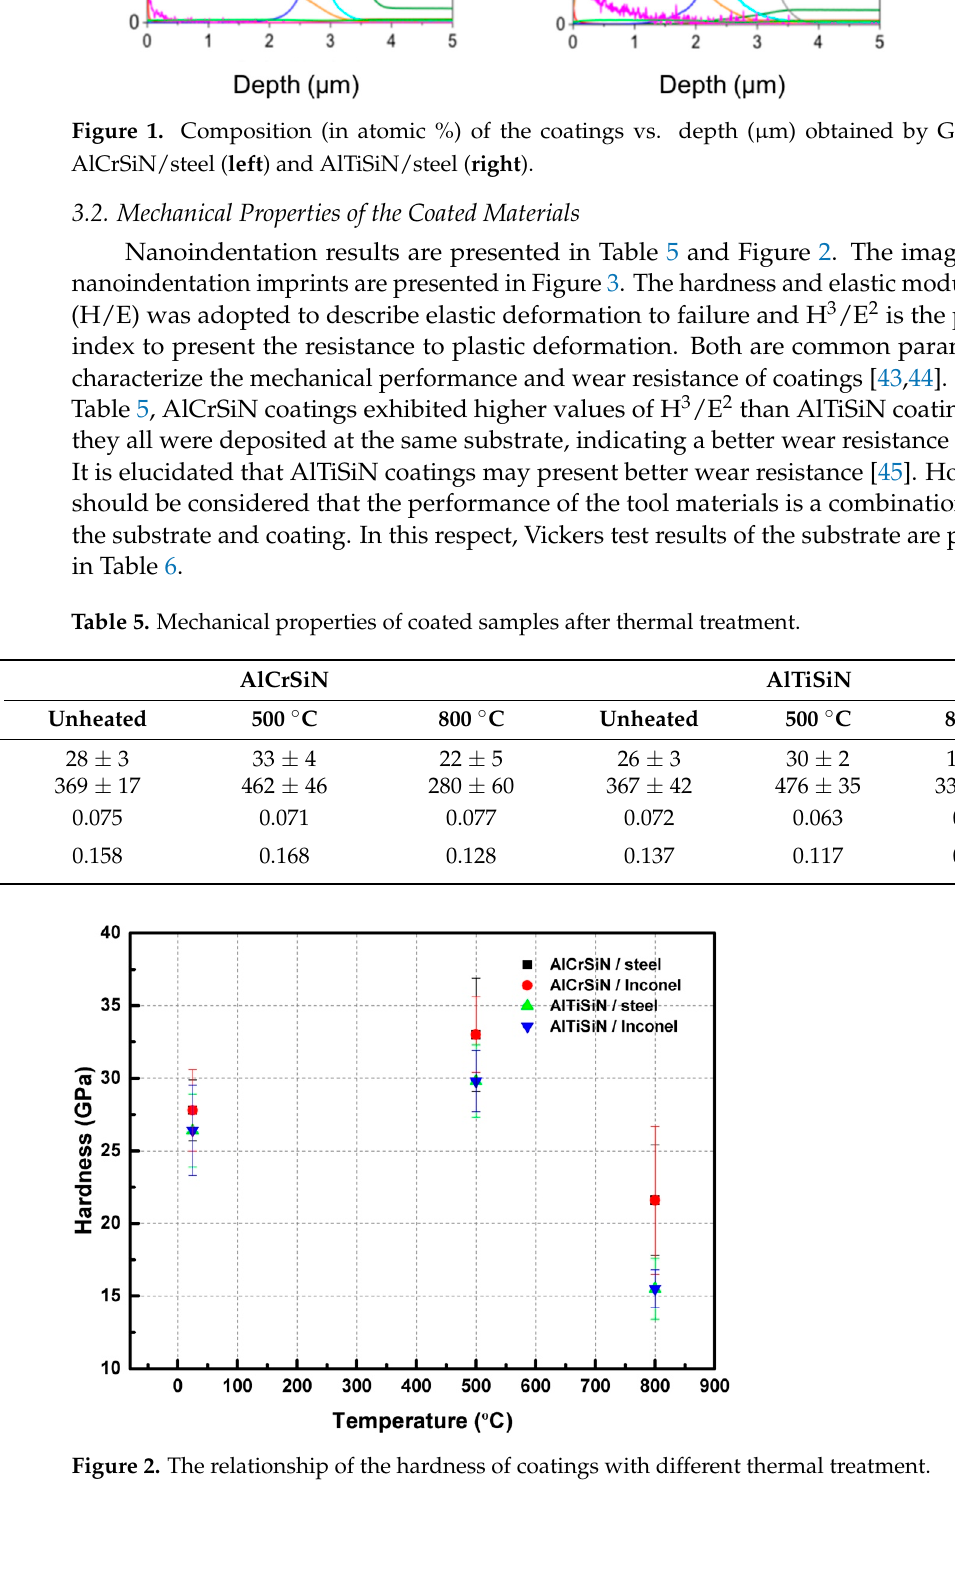
Figure 1. Composition (in atomic %) of the coatings vs. depth ( µ m) obtained by GDOES for Figure 1 . Composition (in atomic %) of the coatings vs. depth (µm) obtained by GDOES for Figure 1 . Composition (in atomic %) of the coatings vs. depth (µm) obtained by GDOES for Figure 1 . Composition (in atomic %) of the coatings vs. depth (µm) obtained by GDOES for AlCrSiN/steel ( left ) and AlTiSiN/steel ( right ). AlCrSiN/steel ( left ) and AlTiSiN/steel ( right ). AlCrSiN/steel ( left ) and AlTiSiN/steel ( right ). AlCrSiN/steel ( left ) and AlTiSiN/steel ( right ).